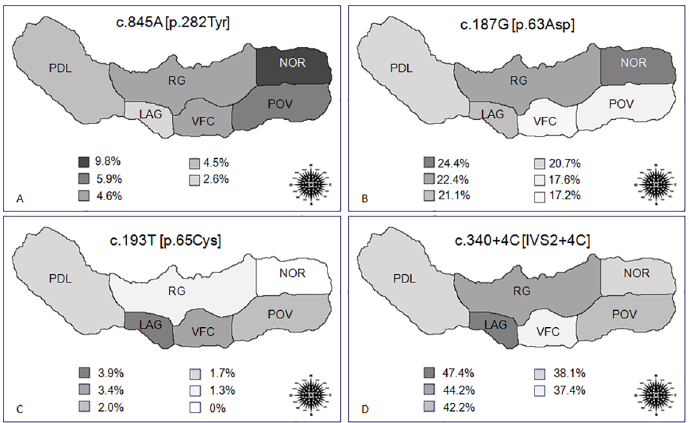
Fig 2. Maps representing the geographical distribution of the allele frequencies (%) of HFE -c.845A (A), -c.187G (B), -c.193T (C) and -c.340+4C (D) mutations in the six S ã o Miguel municipalities. PDL — Ponta Delgada; RG — Ribeira Grande, LAG — Lagoa, VFC — Vila Franca do Campo, POV — Povoaç ã o, NOR —